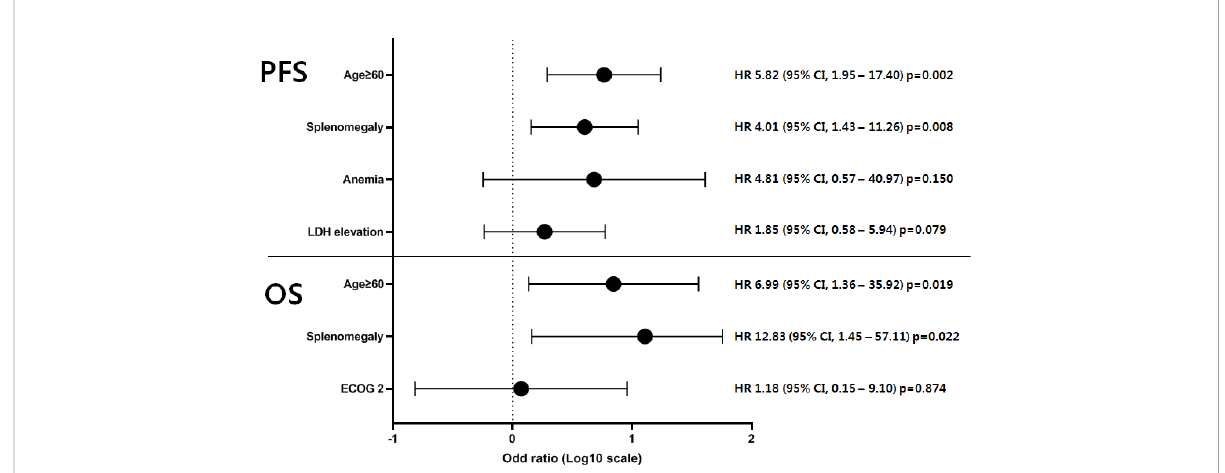
FIGURE 4 Multivariate analysis of prognostic factors in 54 patients with MCD. The prognostic factors of 54 patients with MCD showing clinical signi fi cance in univariate analysis were subjected to multivariate analysis using a Cox regression model. As a result, age ≥ 60 years and splenomegaly signi fi cantly affected the survival outcomes in terms of both OS and PFS. PFS, progression-free survival; OS, overall survival; HR, hazard ratio; CI, con fi dence interval; MCD, multicentric Castleman